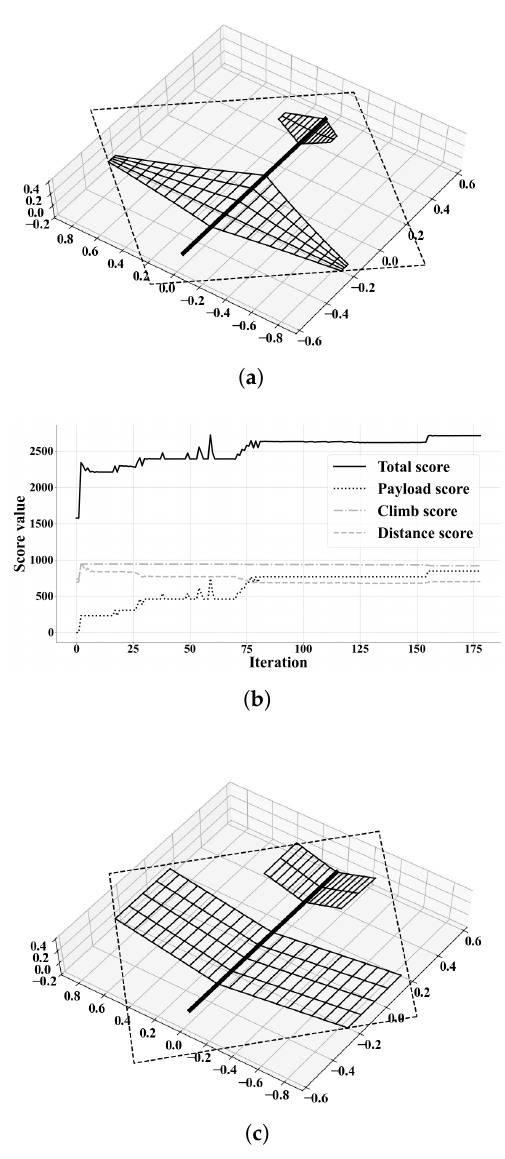
Figure 23. Optimal aircraft design: ( a ) Initial planform; ( b ) Score optimization history; ( c ) Final optimized